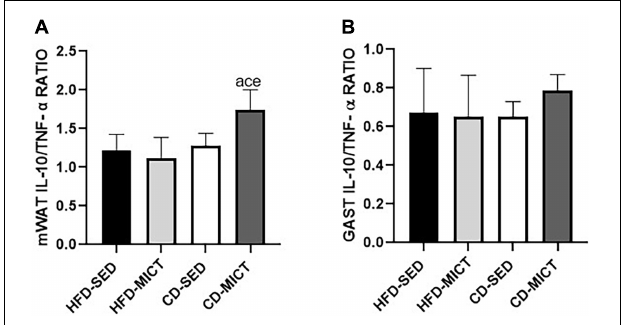
FIGURE 3 | IL-10/TNF- α ratio. (A) Mesenteric adipose tissue (mWAT). (B) Gastrocnemius muscle (GAST). HFD-SED, high-fat diet sedentary ( n = 5); HFD-MICT, high-fat diet plus MICT ( n = 5); CD-SED, chow diet sedentary ( n = 5); CD-MICT, chow diet plus MICT ( n = 5). Data presented as mean ± SEM ( p < 0.05). a vs. HFD-SED; c vs. HFD- MICT; e vs.